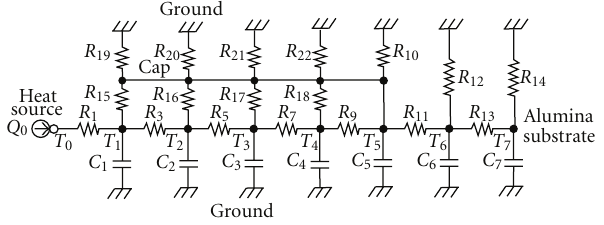
Figure 5: Thermal network model (Model 1).